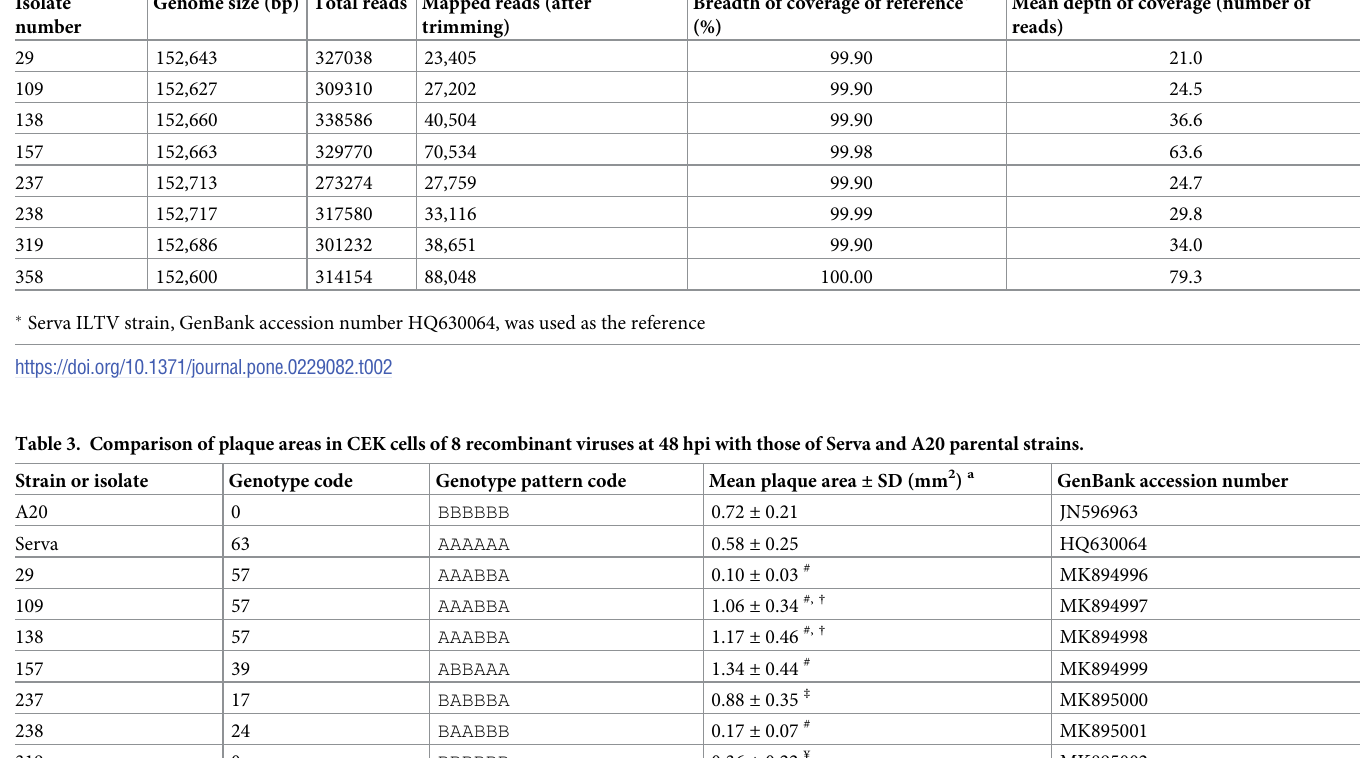
Table 2. Full genome reads and assembly metrics for the 8 isolates selected for full genome sequenced in this study. Isolate Genome size (bp) Total reads Mapped reads (after number trimming)